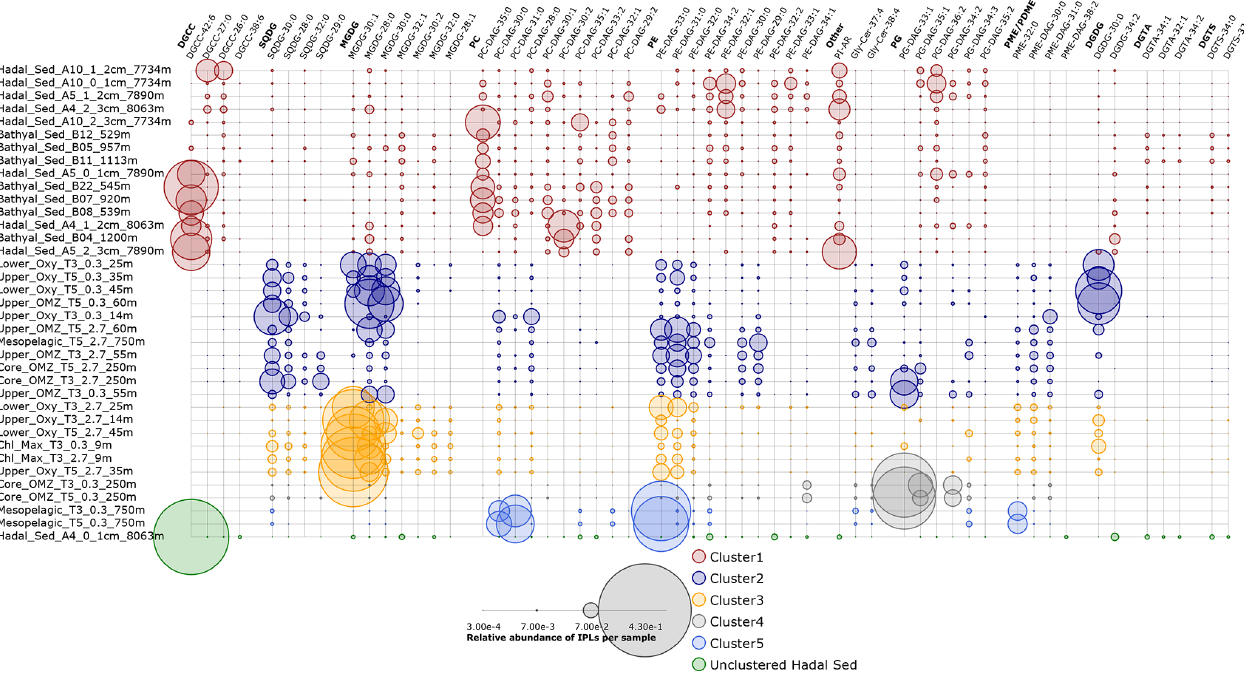
Figure 9. Relative abundance of individual IPLs that contribute most to the dissimilarity between clusters of Fig. 8 derived from the SIMPER analysis (Table S1). Circle size is proportional to the relative abundance of IPL compounds per sample. Samples are organized along the vertical axis and shown in colors that match the hierarchical cluster analysis in Fig. 8. The legend shows the scale for circumference